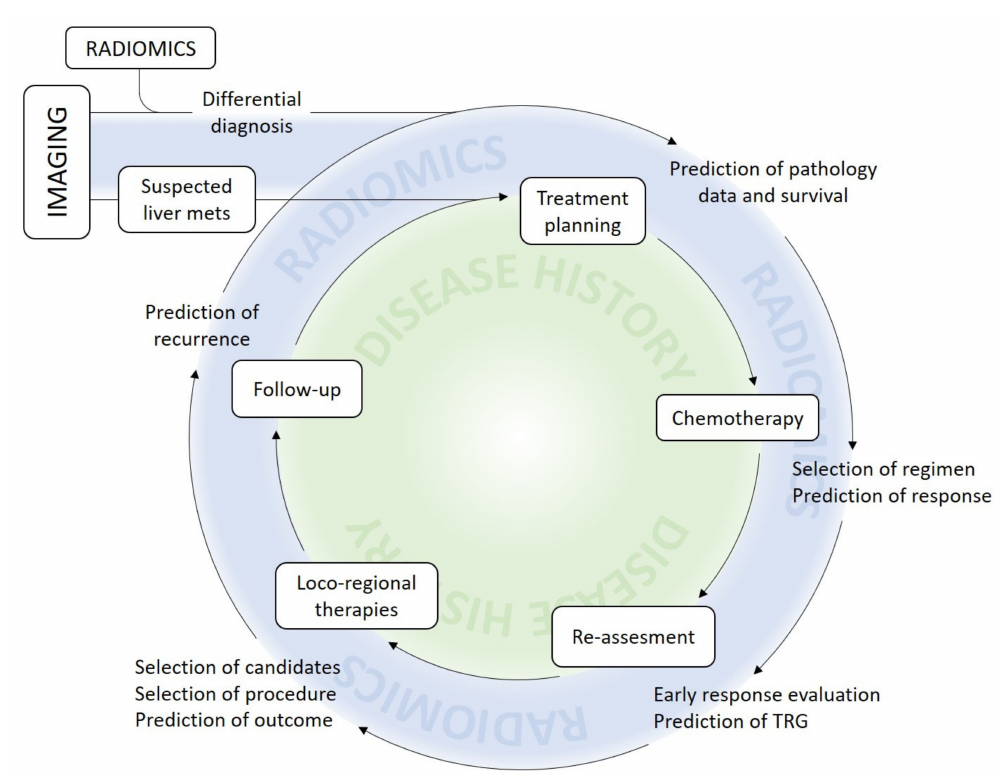
Figure 3. Present and potential future contribution of radiomics to clinical